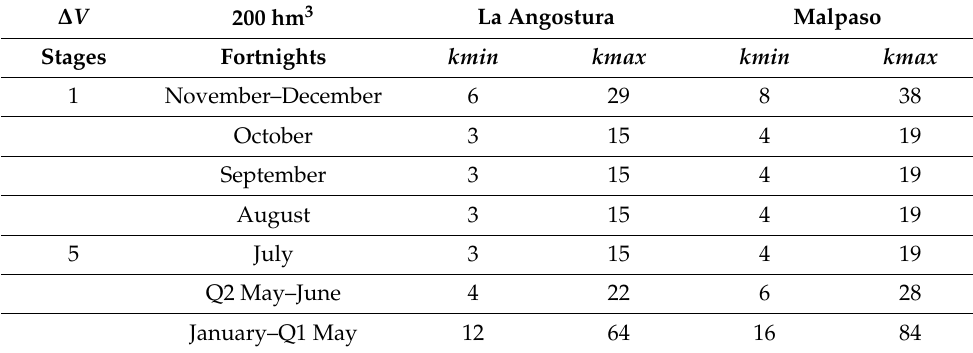
Table 1. Optimization conditions for kmin and kmax .